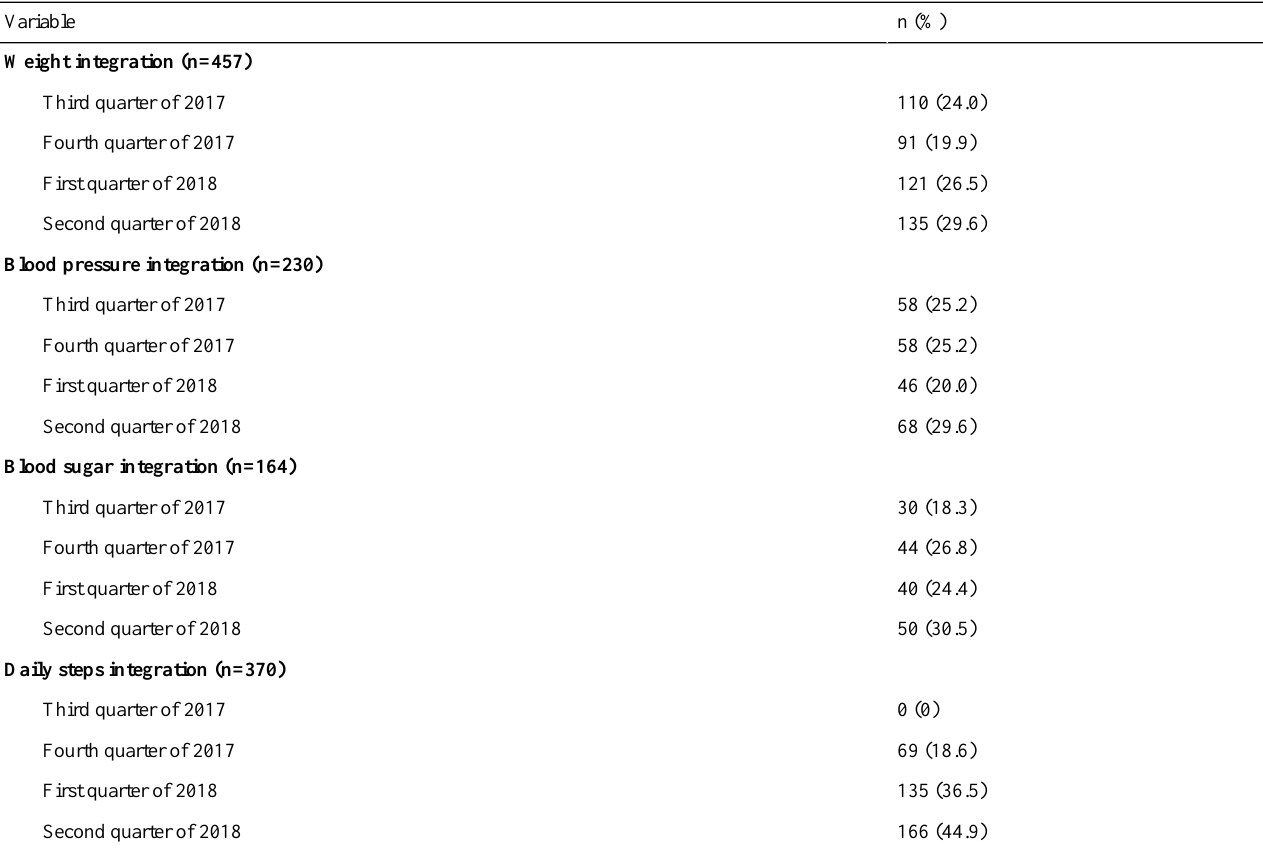
Table 4. Number of patient recordings from the third quarter of 2017 to the second quarter of 2018. The upgraded version of Health4U was launched in the fourth quarter of